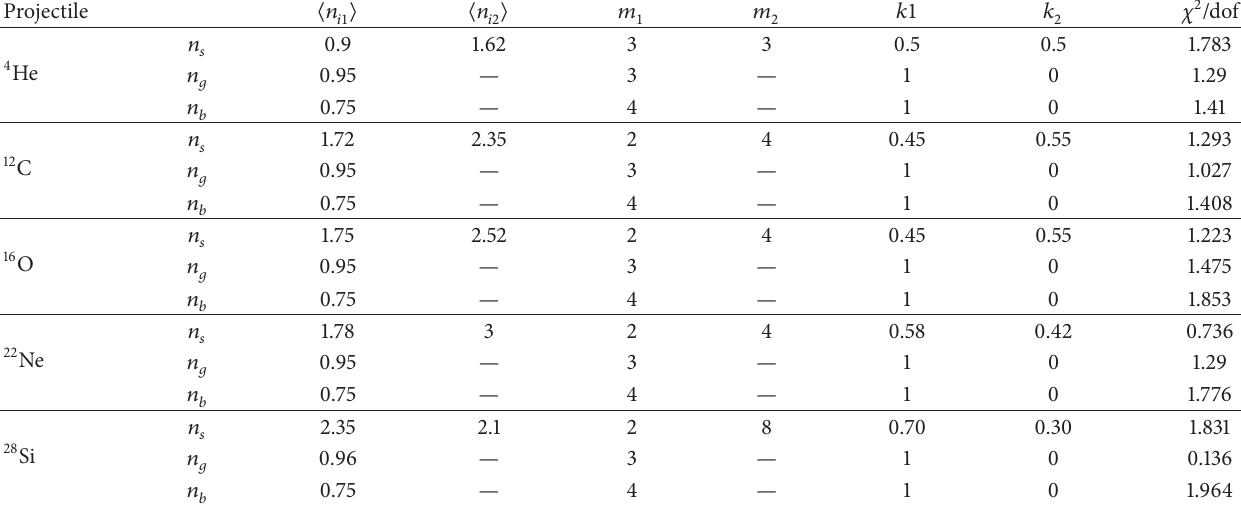
Table 4: Parameter values for multiplicity distributions for shower, grey, and black particles. The values of ⟨𝑛 𝑖1 ⟩ , ⟨𝑛 𝑖2 ⟩ , 𝑚 1 , 𝑚 2 , and 𝑘 1 , 𝑘 2 for 4 He-, 12 C-, 16 O-, and 28 Si-CNO at 4.5 AGeV/c and 22 Ne-CNO at